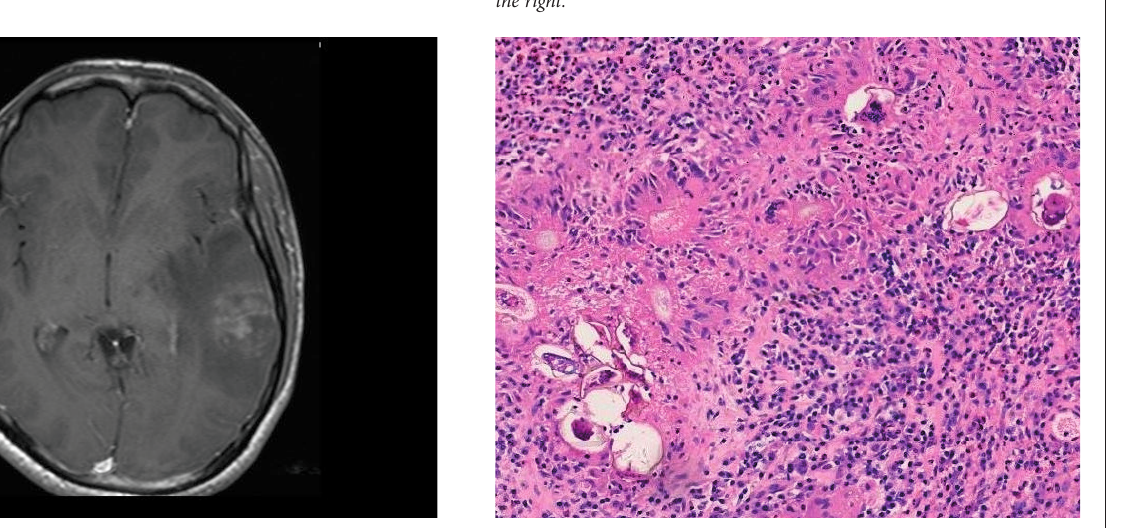
Fig. 4. Haematoxylin- and eosin-stained histopathological specimen following surgical excision, demonstrating numerous granulomas surrounding eggs of S. japonicum . The image also depicts an intense inflammatory